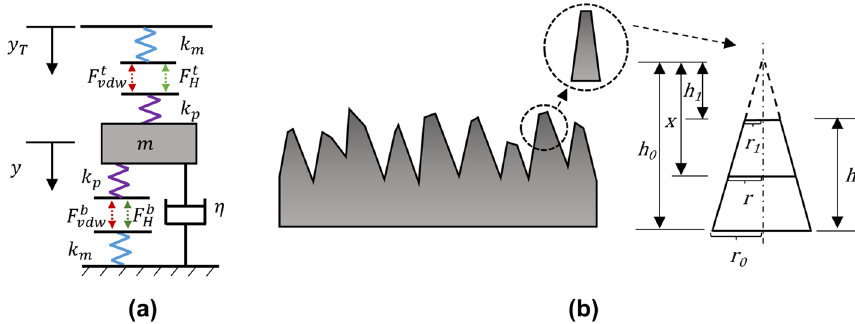
Figure 1. ( a ) Schematic of the model. ( b ) Schematic of the geometry of an